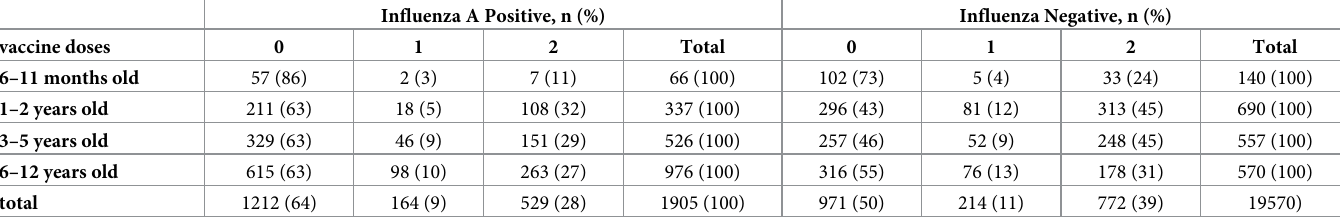
Table 5. Adjusted vaccine effectiveness (VE) of quadrivalent inactivated influenza vaccine by vaccine dose for preventing influenza illness among children in the 2018/19 season. Number of enrollees. Influenza A Positive, n (%) Influenza Negative, n